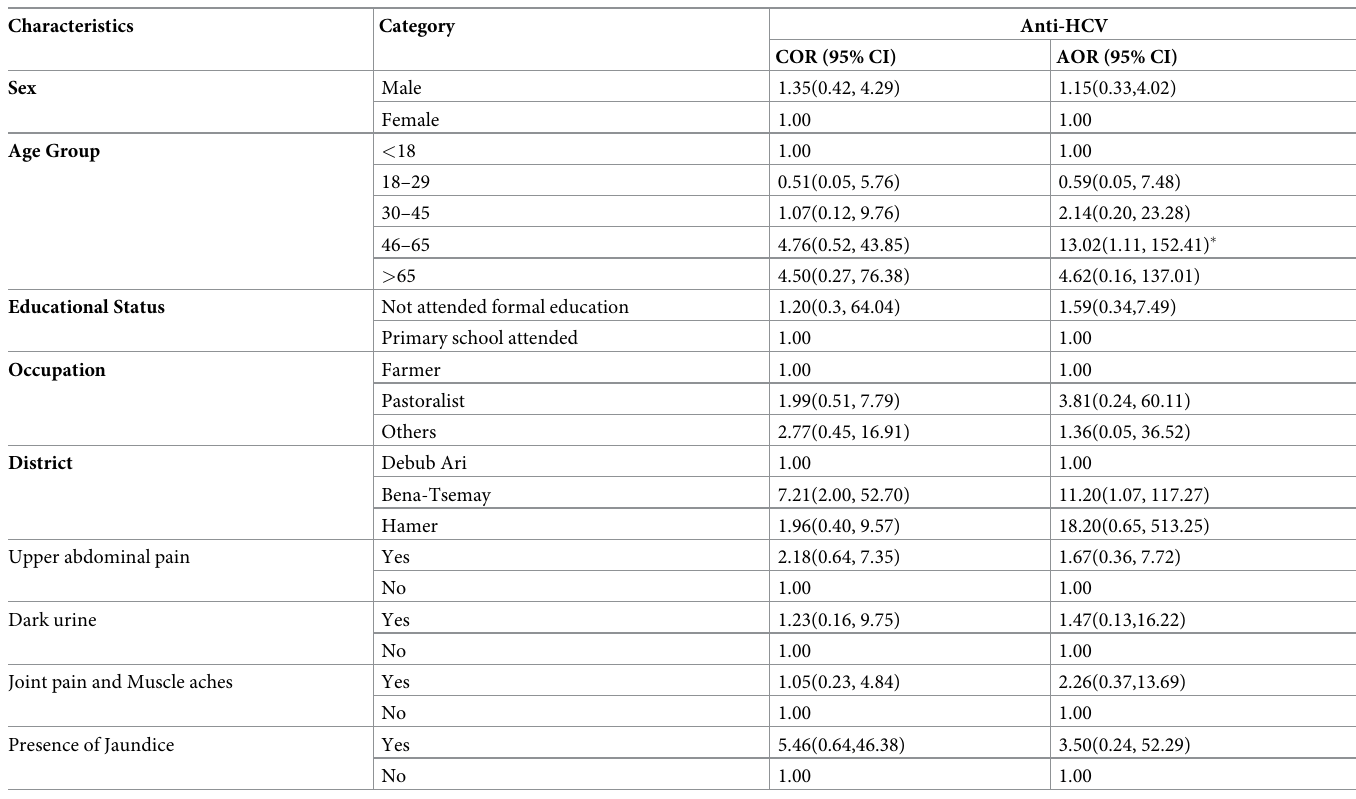
Table 5. Independent predictors of HCV